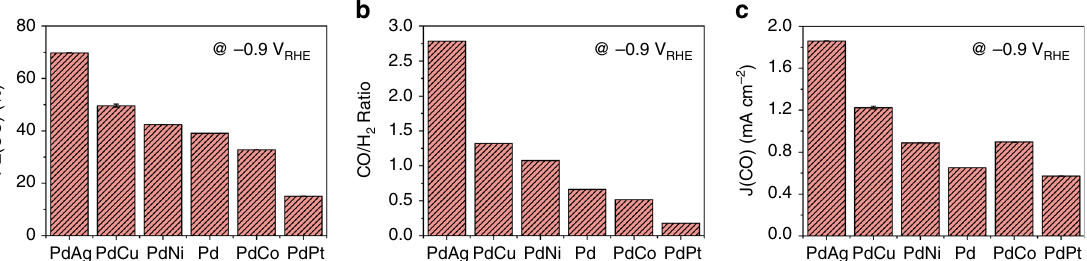
Fig. 1 Electrocatalytic performance of different catalysts at − 0.9 V RHE . a Faradaic ef fi ciency (FE(CO)) of CO. b CO/H 2 ratio. c Partial current density (J (CO))